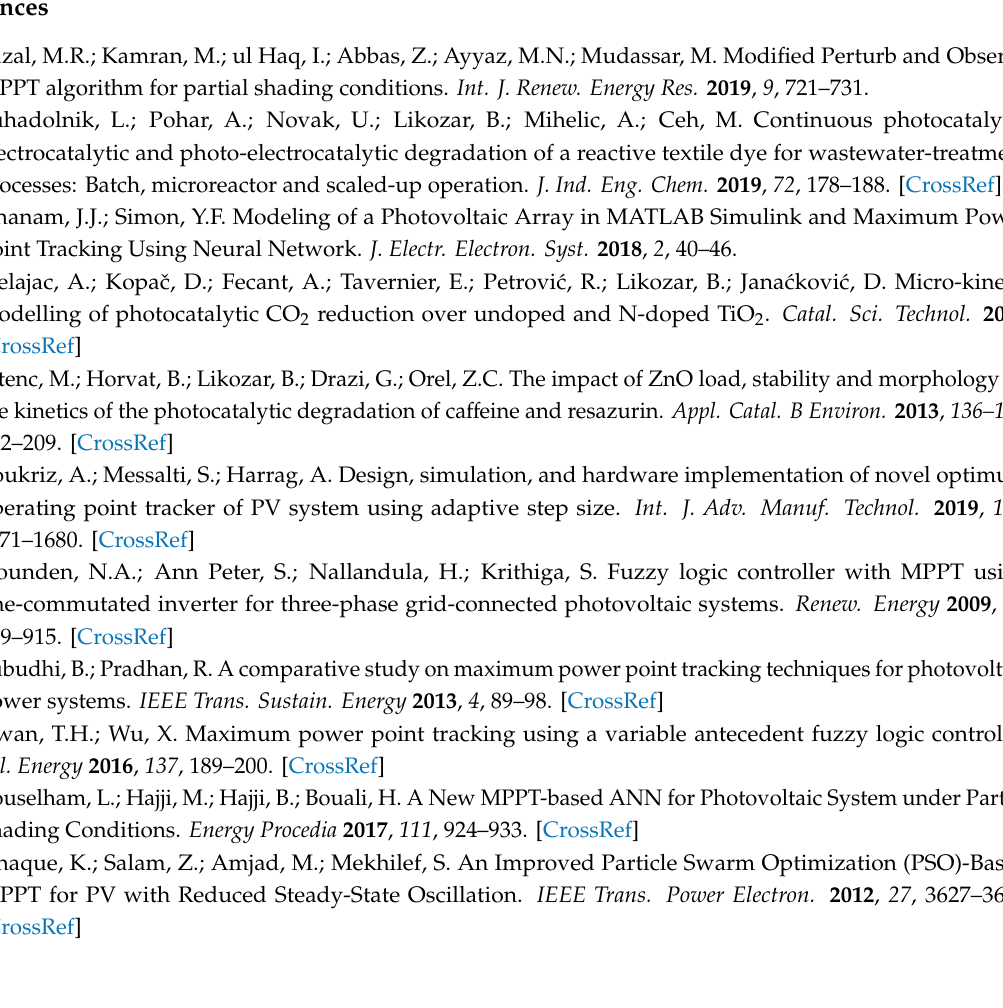
Figure A1. I–V and P–V curves of the PV array under different irradiance levels.